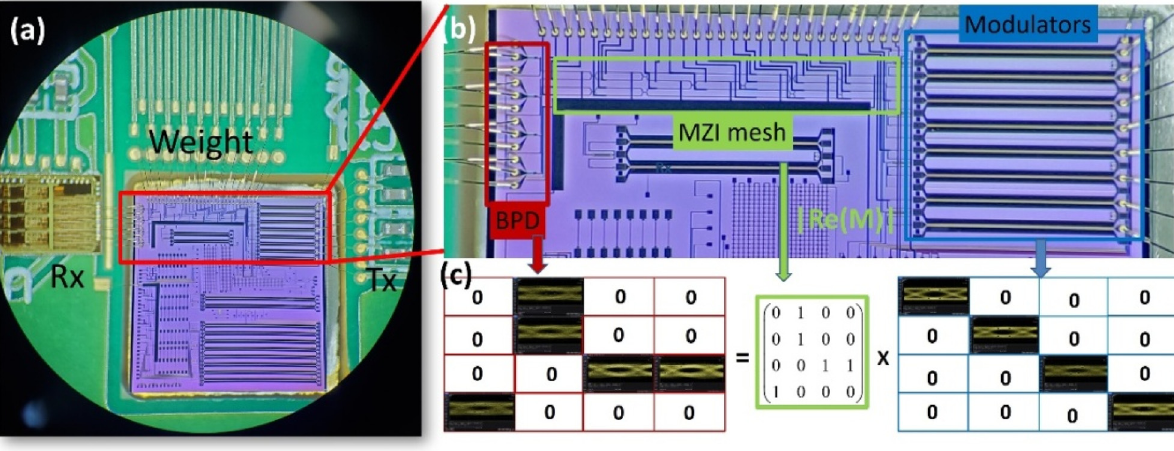
Figure 8: The feasibility of the pseudo-real-value MZI mesh to run matrix multiplication at high time-clock. (a) Packaged active silicon photonic chip with pseudo-real-value matrix multiplier; (b) Microscopy of the chip highlight the modulators array, balanced photon detectors (BPD) and MZI mesh; (c) matrix multiplication at 25 GHz demonstrated via eye diagram